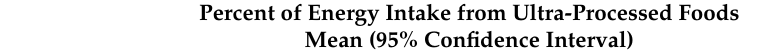
Table 3. Healthy Eating Index 2015 (HEI) total score and food group intake density by category of ultra-processed food